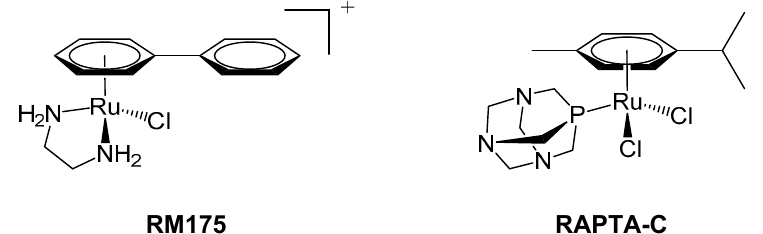
Figure 1. RM175 ( left ) and RAPTA-C ( right ) are typical examples of 18-electron ruthenium arene “piano-stool” complexes, in which an η 6 -arene ring stabilises the 2+ oxidation state of the ruthenium metal centre.